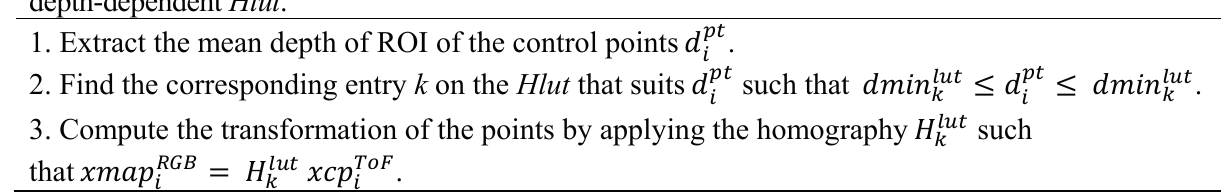
Algorithm 2 Procedure for mapping points between two views (ToF → RGB) based on the depth-dependent Hlut .